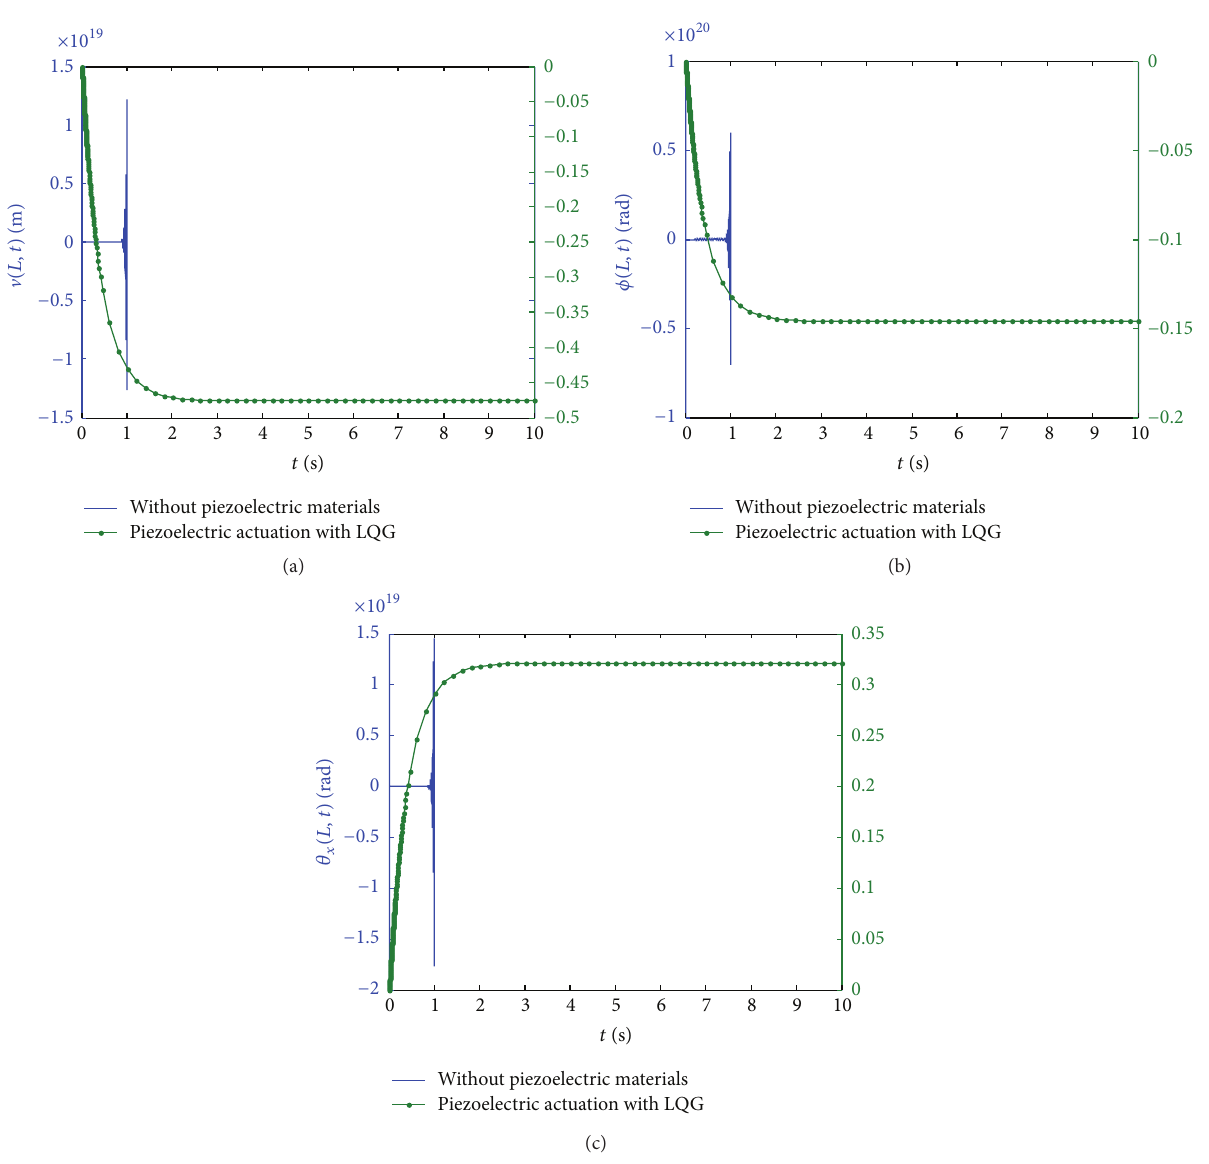
Figure 5: The time responses of the three displacements for wind velocity of 𝑈 = 38 m/s, which are characterized by the state without piezoelectric materials and actuation by LQG